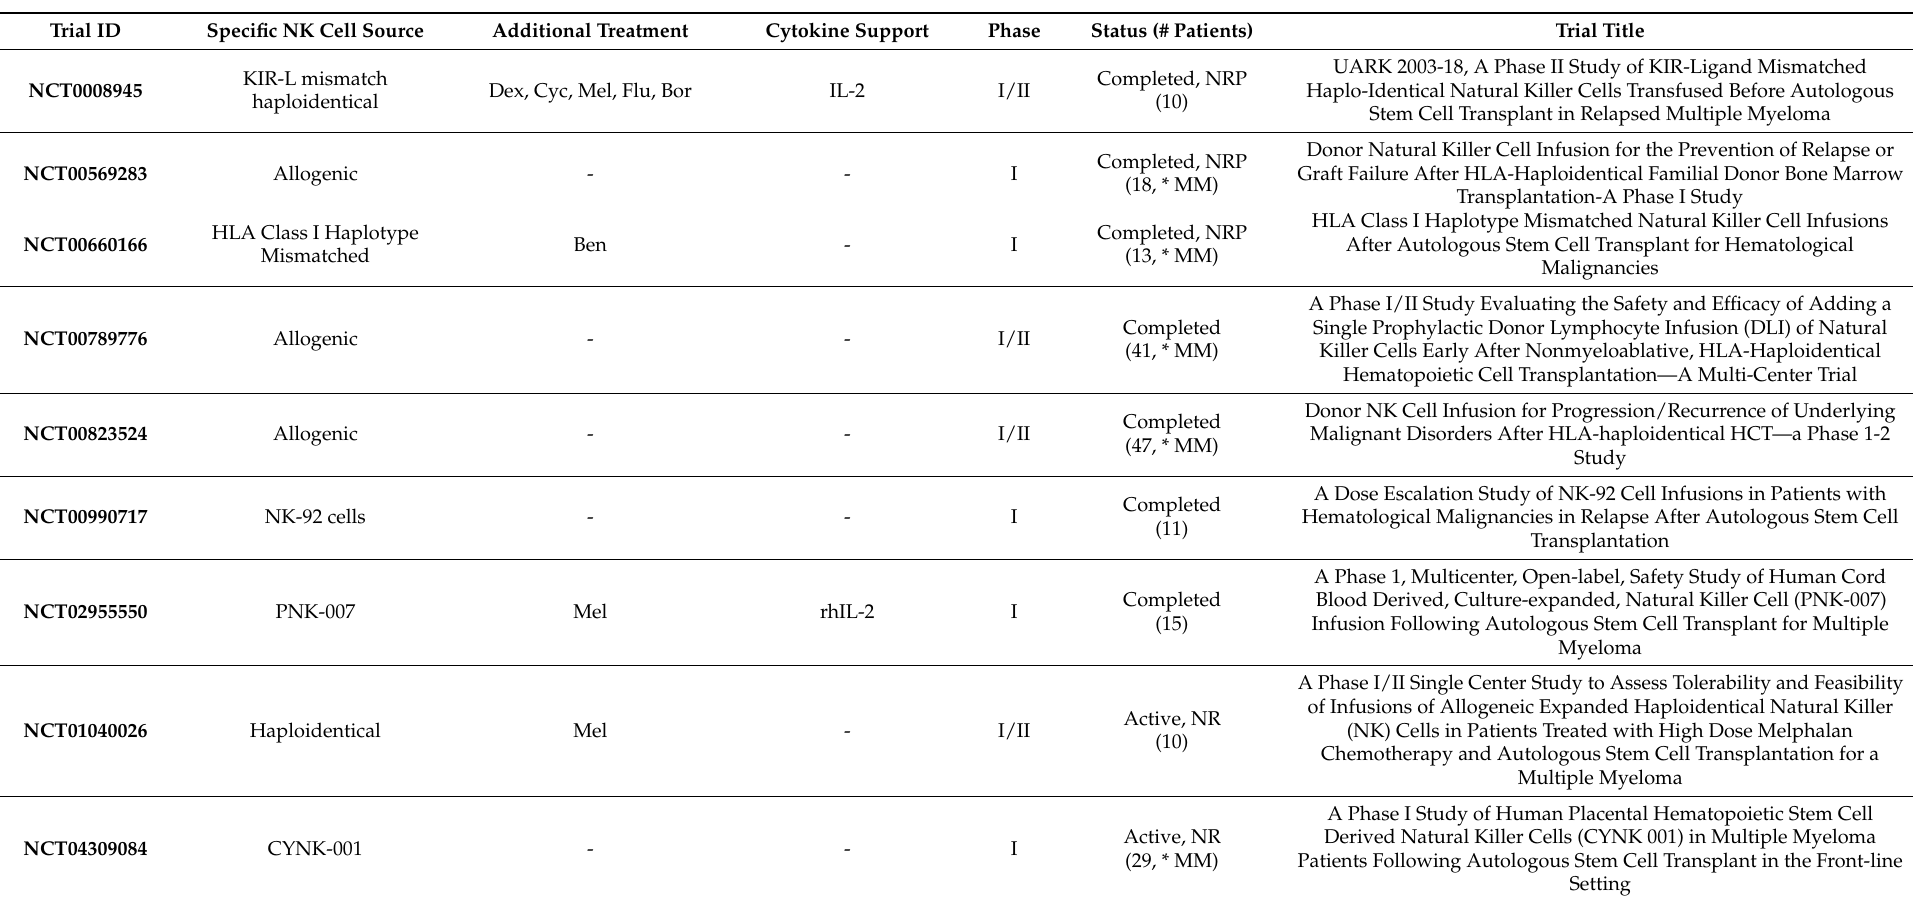
Table 2. Clinical trials based on allogenic NK cell infusions. Dex—dexamethasone, Cyc—cylophosphamide, Mel—melphalan, Flu—fludarabine, Bor—bortezomib, Elo—elotuzumab, Len—lenalidomide, Myc—mycophenolate mofetil, Rit—rituximab, ATG—anti-thymocyte globulin, Bus—busulfan, Clo—clofarabine, NR—not recruiting, NRP—no results posted, * MM indicates that the trial was done in a variety of tumor types and that the number of MM patients was not